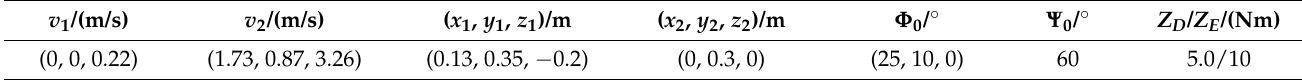
Table 2. Known values during optimization for example 1.